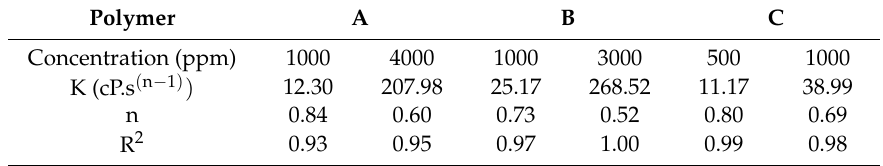
Figure 4. Shear viscosity of prefiltered bulk solutions A, B and C in 1 wt. % NaCl at 22 ◦ C. Solid lines represent the power law model. Table 3. Power law fitting parameters K, n and coefficient of determination R 2 .